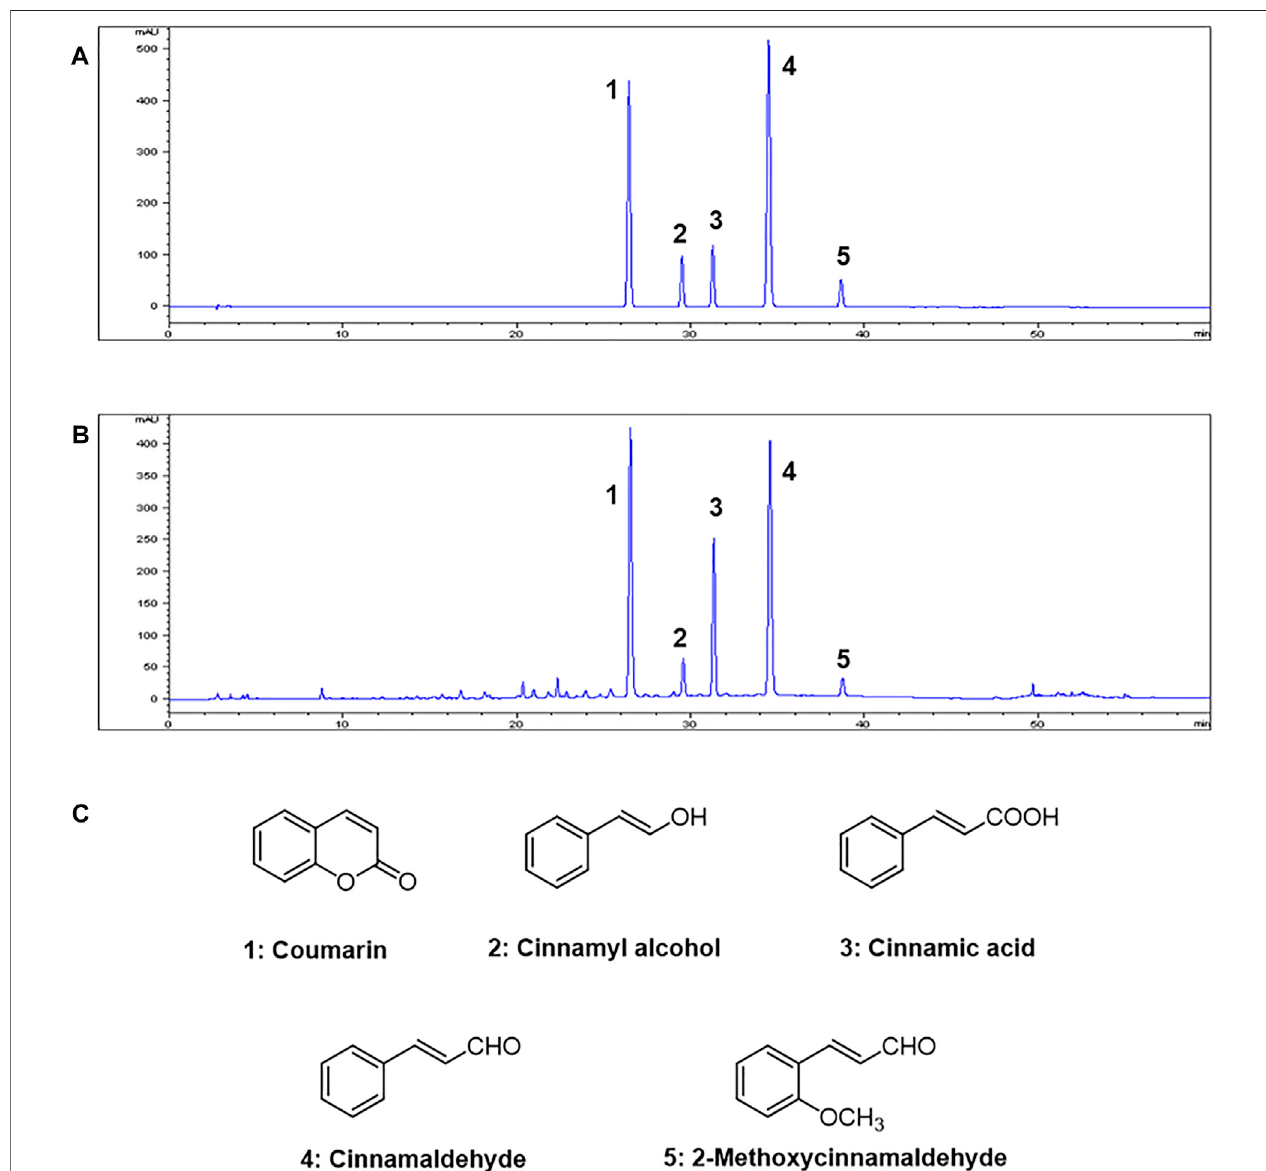
FIGURE1| HPLCchromatograms of (A) Fivestandardcompoundmixturesand (B) Ethanolicextract(70%)of C.cassia (L.)J.Presl. (C) Chemicalstructuresof fi ve compounds. Peak identi fi cation: 1, coumarin; 2, cinnamyl alcohol; 3, cinnamic acid; 4, cinnamaldehyde; 5, 2-methoxycinnamaldehyde. Detection was at 260 nm.